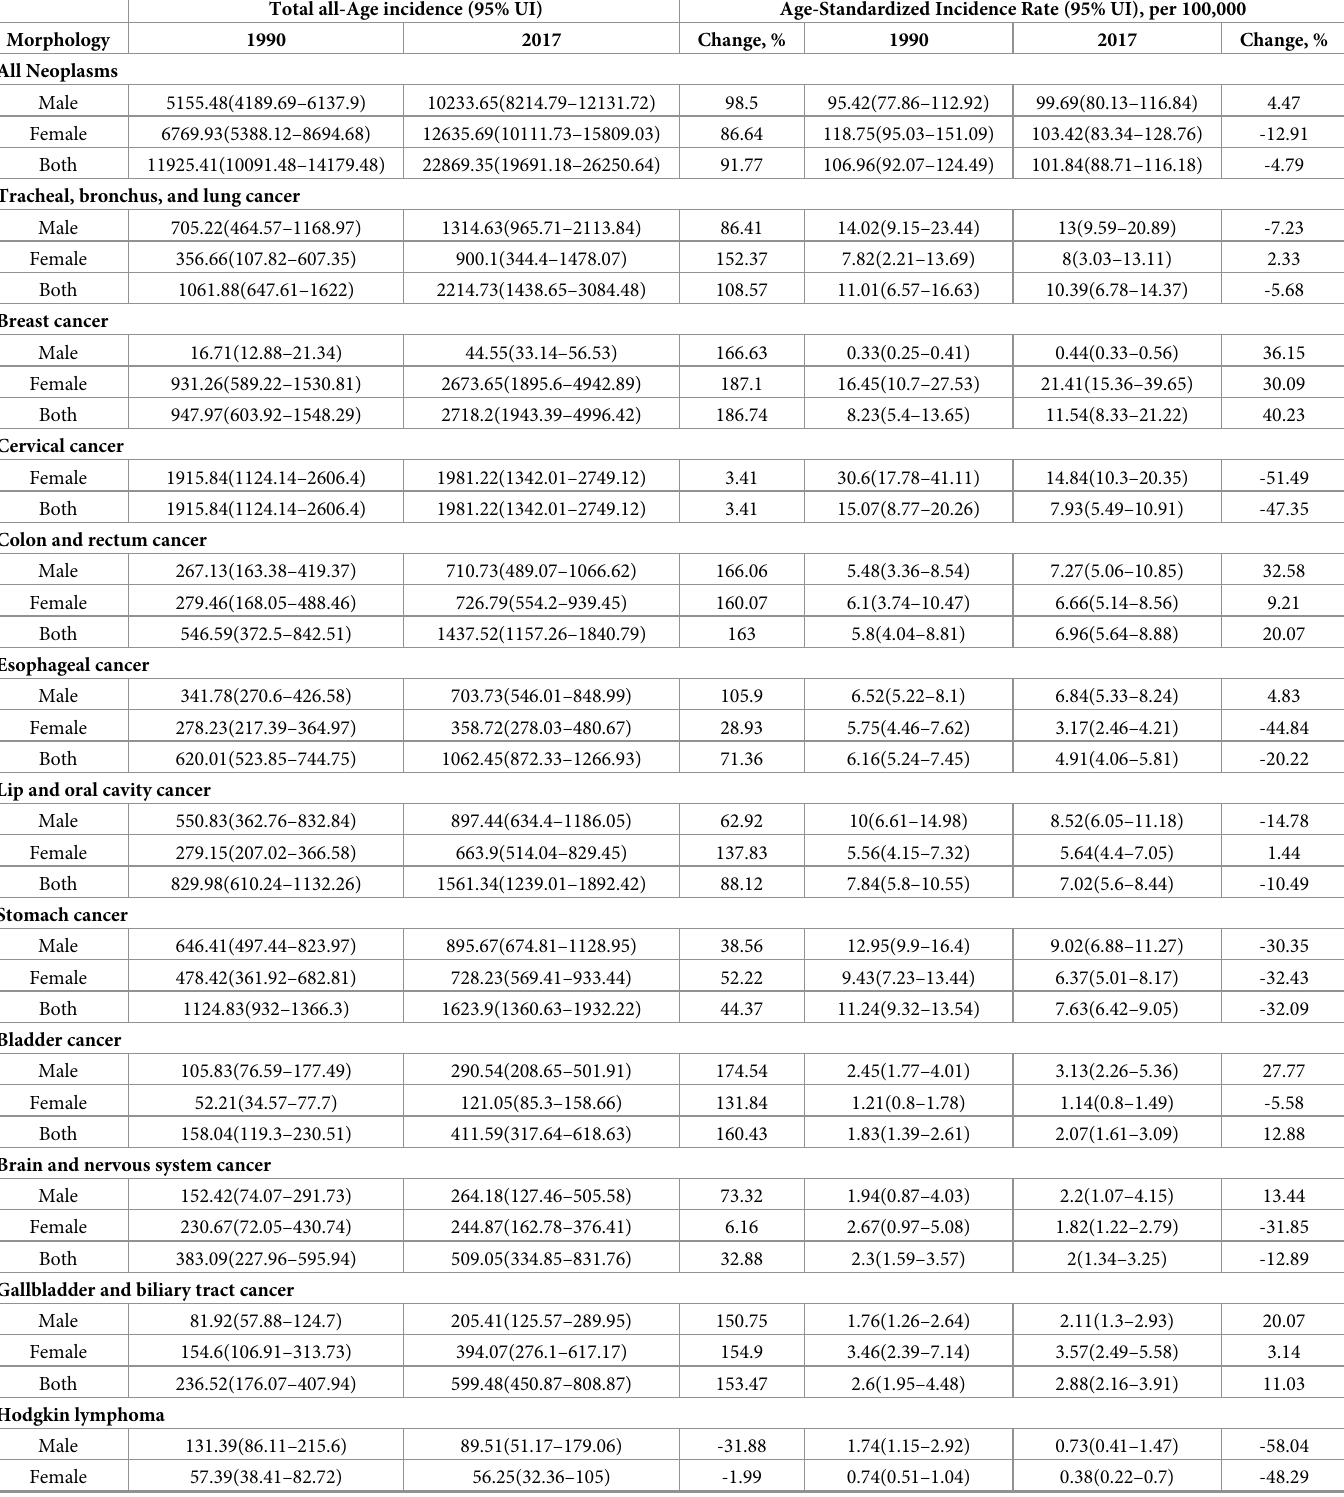
Table 1. Total all-age incidence and age-standardized incidence rates for different types of cancer and their percentage change by gender in Nepal,